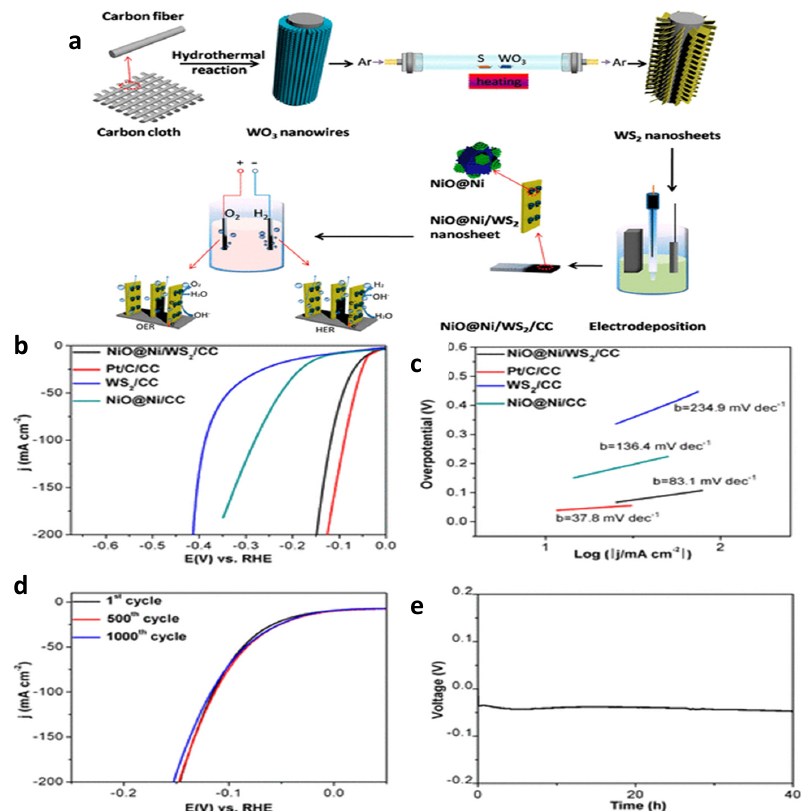
Figure 5. ( a ) Schematic illustration of the synthesis process of NiO@Ni/WS 2 /CC ( b ) The LSV curves for NiO@Ni/WS 2 /CC, WS 2 /CC, Pt/C/CC, and NiO@Ni/CC with a scan rate of 5 mV s − 1 for HER. ( c ) LSV curves for NiO@Ni/WS 2 /CC, RuO 2 /CC, and NiO@Ni/CC with a scan rate of 5 mV s − 1 for OER. ( d ) OER corresponding Tafel plots of NiO@Ni/WS 2 /CC, RuO 2 /CC, and NiO@Ni/CC. ( e ) Chronopotentiometric curve of NiO@Ni/WS 2 /CC with constant current density of 50 mA cm − 2 . Reproduced with permission [139]. Copyright 2018, American Chemical